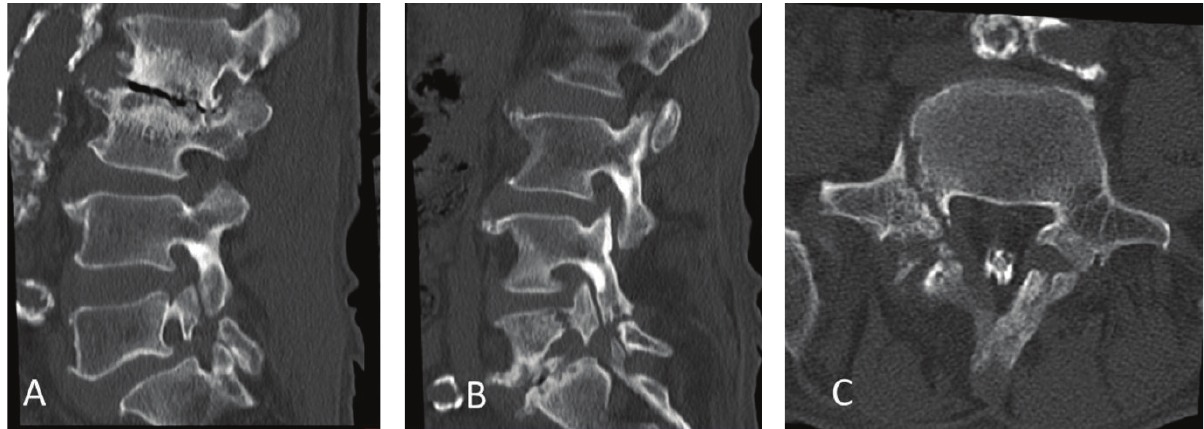
Figure 4: Sagittal reconstruction CT confirming bilateral spondylolysis and destructive changes at L2-L3 and L5-S1 (A, B). Axial CT and right-side parasagittal reconstruction CT confirming right-side L5 pedicle fractures (B, C).